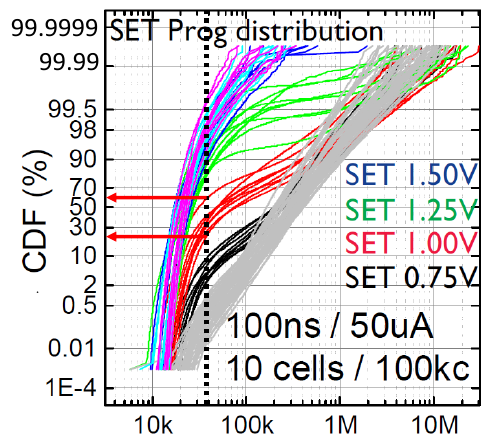
Figure 14: The measured SET failure probability of 10 devices with four different V set (figure in [FGR + 14]). The failure probabilities at 1V show a deviation about 30-40% within only 10 devices. The grey curves are the resistive state before SET